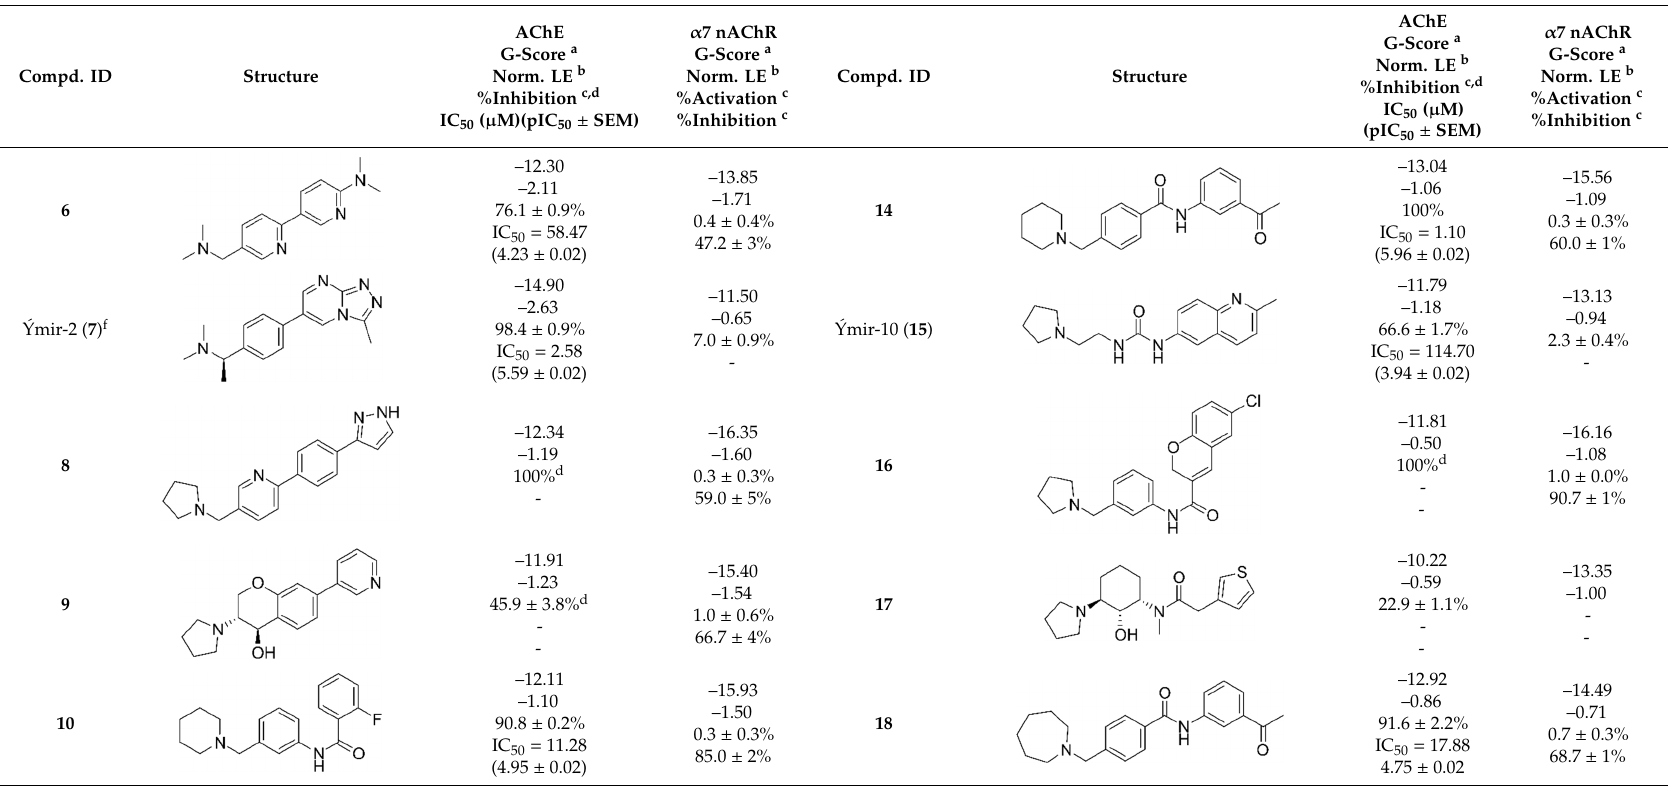
Table 1. Docking and in vitro results for tested compounds ( 6 – 21 ). For AChE, compounds were initially screened at 200 µ M followed by IC 50 measurements for soluble compounds with ≥ 80% inhibition. For α 7 nAChR agonism, activities were measured at 200 µ M concentrations. For determination of modulation of ACh responses at the α 7 nAChR, 100 µ M compound was co-applied with 30 µ M ACh. Measured data represent the mean ± S.E.M of at least three AChE replicates and independent oocyte